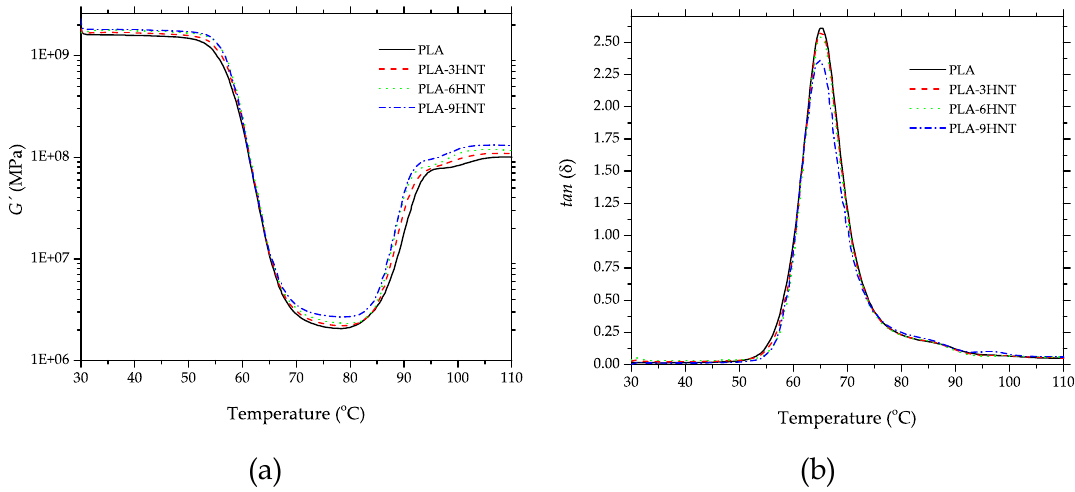
Figure 7. Plot evolution of the dynamic mechanical thermal properties (DMTA) for PLA-HNTs composites with different HNTs loading a ) storage modulus, G’ and b ) dynamic damping factor, tan δ . Table 4. Summary of some dynamic mechanical thermal properties of PLA-HNTs composites with different HNTs loading obtained by DMTA.